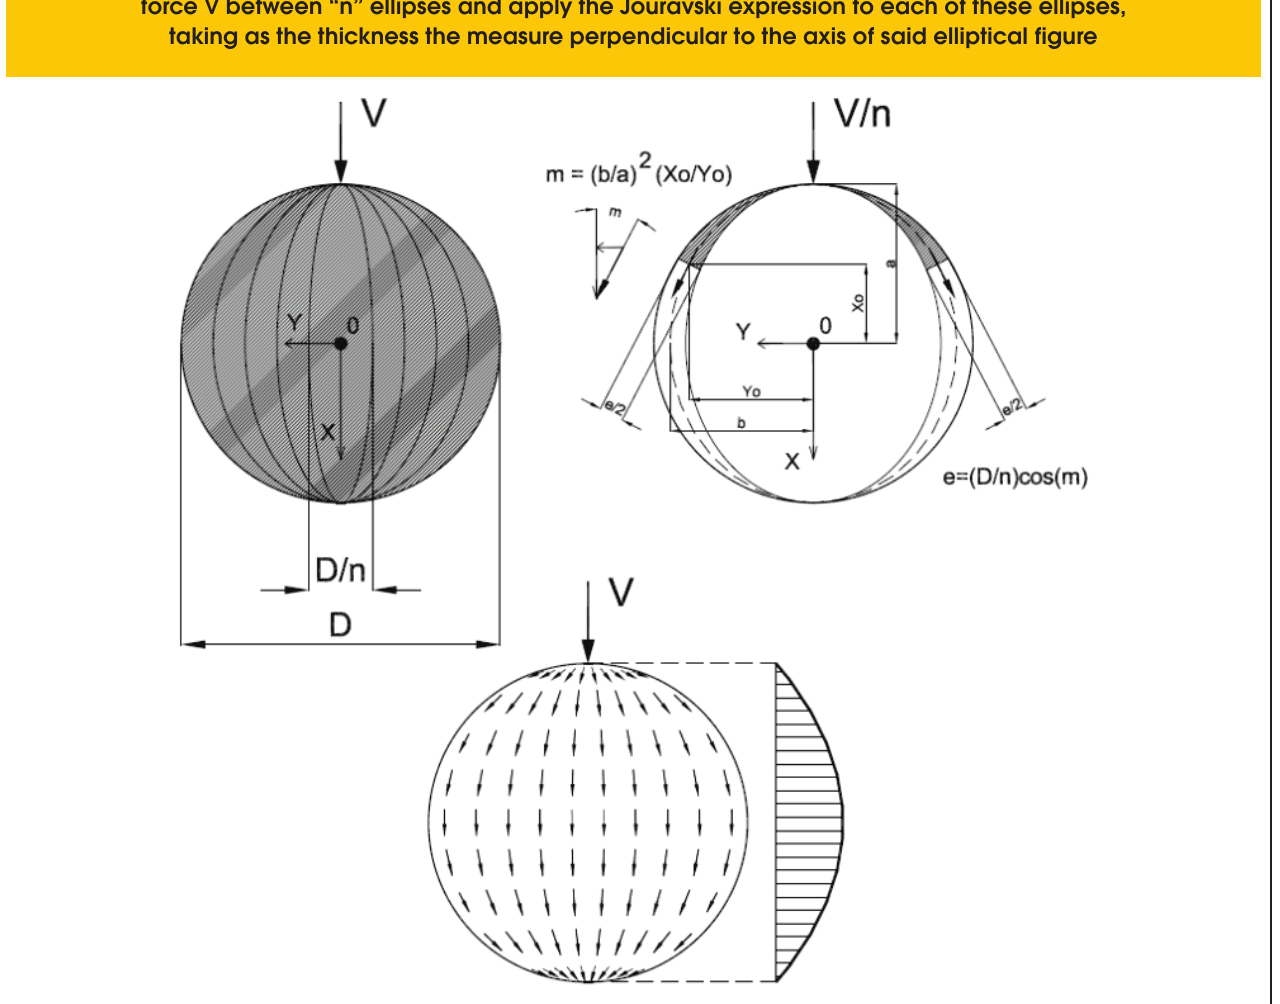
Figure 4 – Simplified procedure for determining the tangential stresses at all points of a circular cross section with use of Jourávski formula: divide the shear force V between “n” ellipses and apply the Jourávski expression to each of these ellipses, taking as the thickness the measure perpendicular to the axis of said elliptical